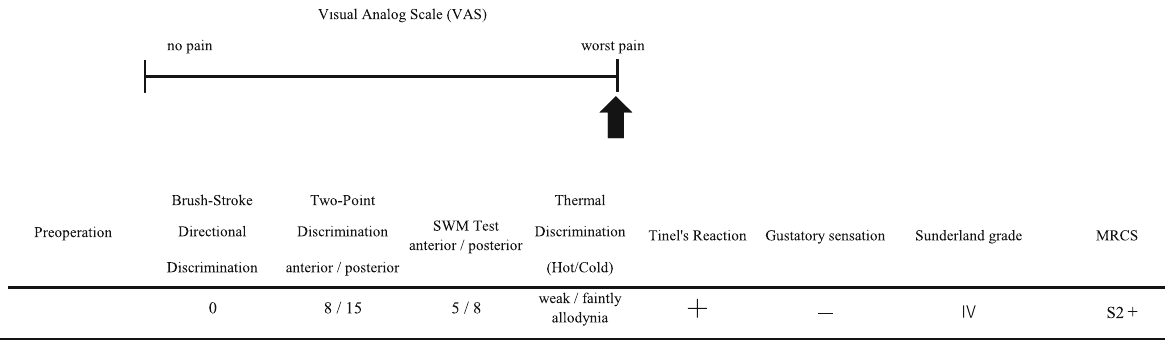
Table 1 Preoperative data of visual analog scale and another various